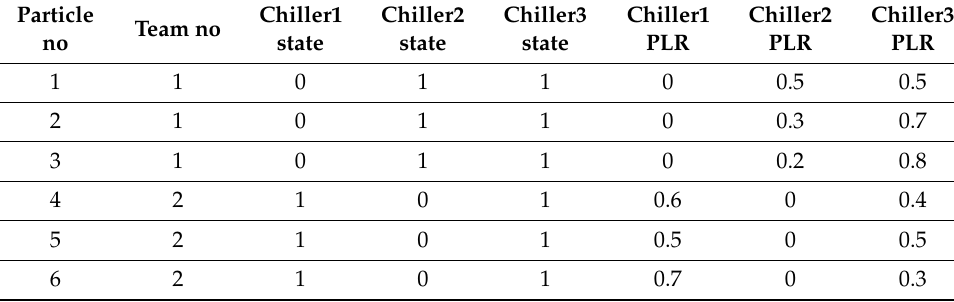
Table 3. Step 3: set up the random PLR value of chillers for each